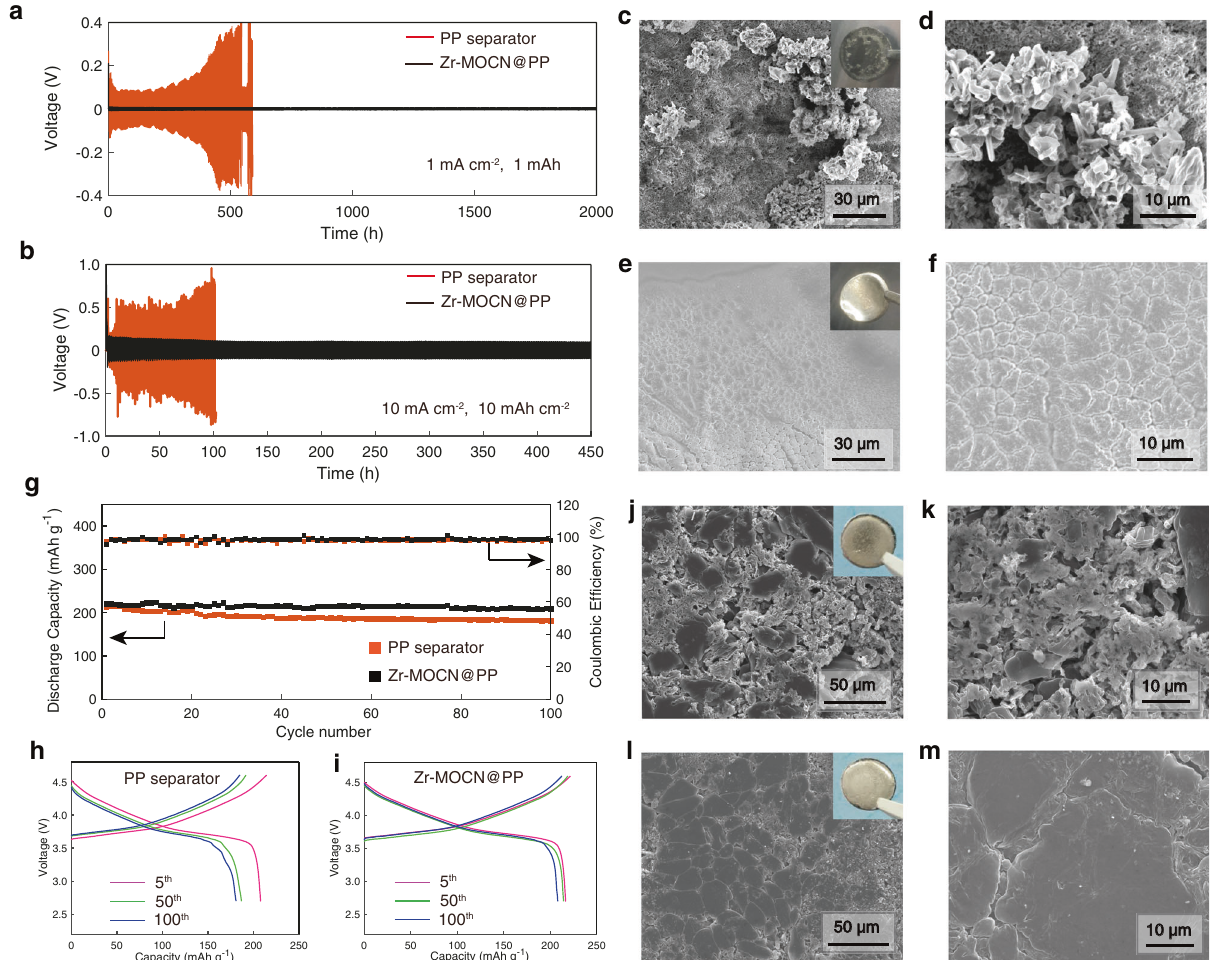
Fig. 2 Electrochemical performance and morphology of cycled lithium metal in Li-symmetric cells and Li | NMC622 cells. Initial voltage pro fi les of the PP separator (red) and Zr-MOCN@PP (black)-based cells at a fi xed current density of: a 1 mA cm − 2 . b 10 mA cm − 2 . Top-view SEM images of the lithium metal after 340 h stripping/plating in c , d . The PP separator-based symmetric lithium cell; e , f Zr-MOCN@PP-based symmetric lithium cell; insets are photos of the corresponding lithium metal electrode. g Cycling stability and Coulombic ef fi ciency of Li | NMC622 cells with the PP separator (red) and Zr- MOCN@PP (black) at 0.2 C rate; the voltage range of charge and discharge is 2.7 – 4.6 V. h , i Charge/discharge voltage pro fi les with the PP separator and Zr-MOCN@PP based cells, respectively. SEM images of Li metal after 100 cycles with: j , k PP separator, l , m Zr-MOCN@PP separator; insets are photos of the corresponding lithium metal